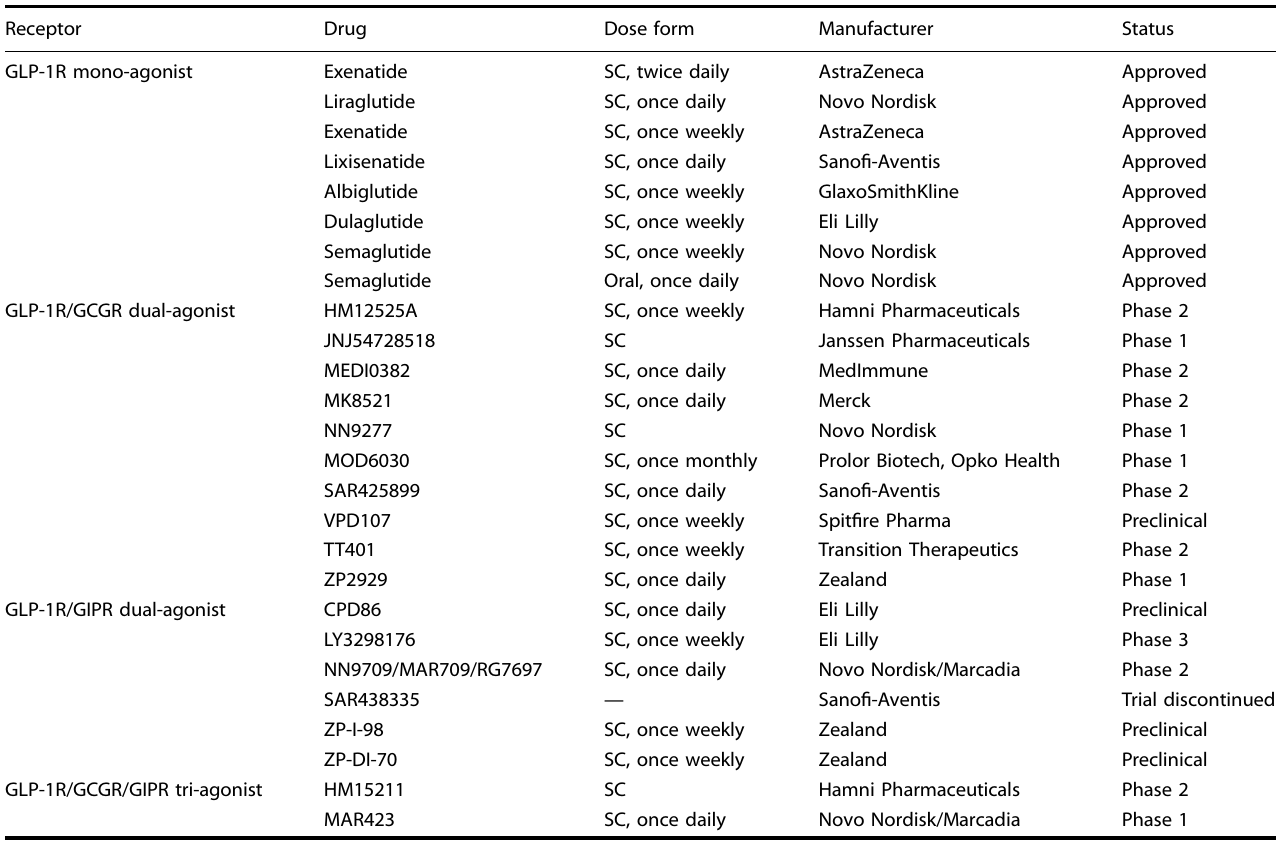
Table 3. Mono-, dual- and tri-agonists targeting GLP-1R, GCGR, and